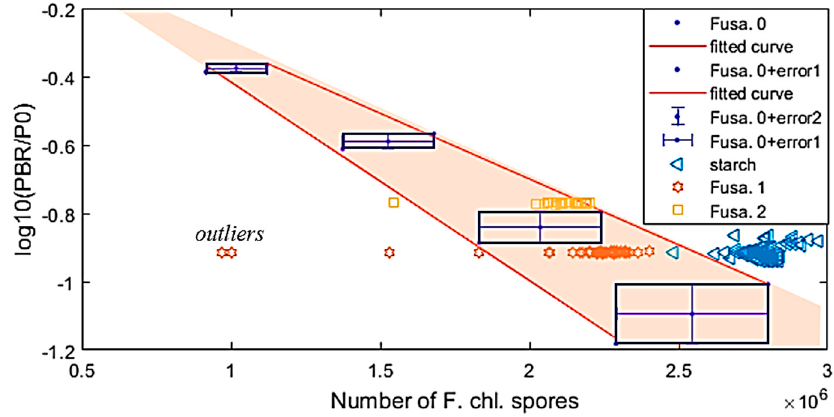
Figure 14. f BR = fitting (N, log ( P BR Figure 14. 𝑓 (cid:3003)(cid:3019) = fitting (N, log ( (cid:2900) (cid:3134)(cid:3150) (26) and (26) and (27).